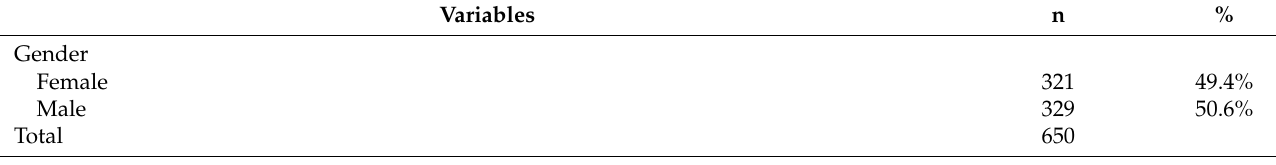
Table 1. Demographic characteristics of the study participants when they were in the fourth grade of elementary